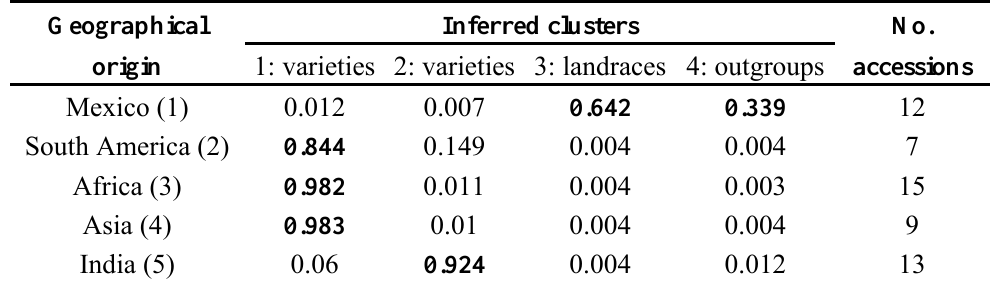
Table 5. Proportion of membership to the four inferred clusters of each of the five Jatropha subgroups pre-defined according to their geographical